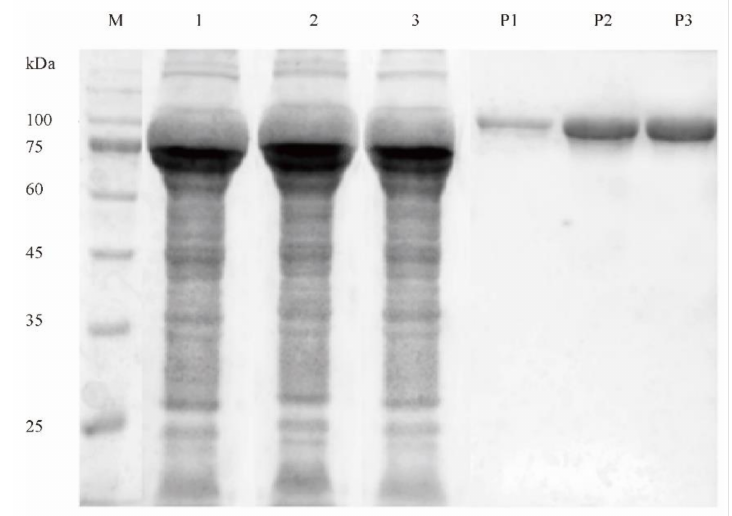
Figure 2. SDS-PAGE analysis of the purified DPEases. M, protein marker; lane 1–3, supernatant of